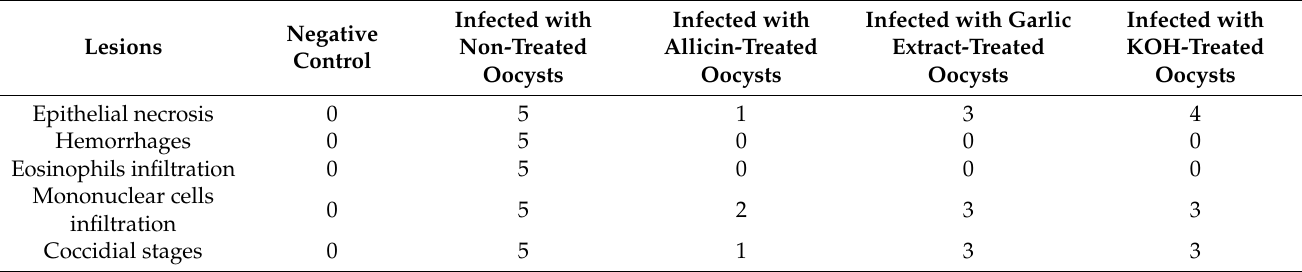
Table 3. Scoring of the histopathological findings of cecal sections of different experimental groups.